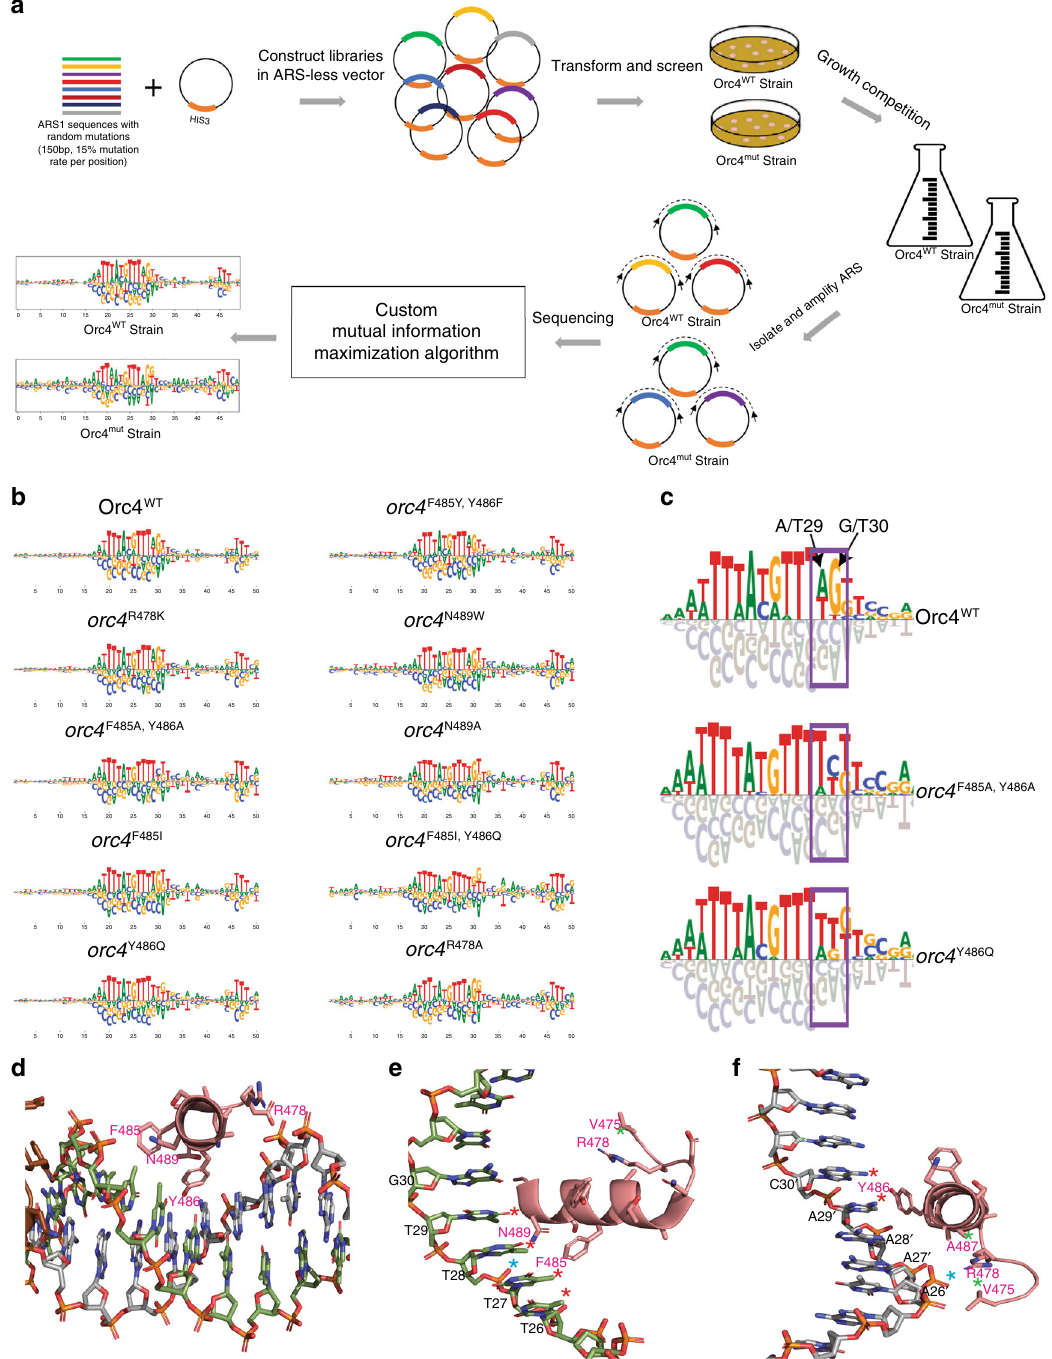
Fig. 2 Selected origin sequence changes using a massively parallel origin selection (MPOS) assay. a Schematic diagram of the MPOS assay. b ARS motifs for Orc4-integrated variants at A and B1 elements generated using an ARS1 (ARS416) variant library. See “ Methods ” for how motifs are graphically rendered. c Magni fi ed view of the A element region in b from Orc4 WT , orc4 F485A, Y486A , orc4 Y486Q strains. Dark purple rectangles indicate the major changes at positions 29 – 30 in the Orc4 mutant strains. d Top-view of Orc4 α -helix insertion from ORC – DNA structure at 3 Å (PDB code 5zr1) positioned in the DNA major groove. F485, Y486, N489, and R478 interact with DNA in base-speci fi c (speci fi city) and base-nonspeci fi c (af fi nity) manner. e and f Same as in d , but viewed at different angles. Red asterisks denote the base-speci fi c interactions between amino acid and DNA base. Blue asterisks denote the base-nonspeci fi c interaction between amino acid and DNA phosphate backbone. Green asterisks denote the interaction between amino acids. Prime symbols denote bases on the opposite strand. Bases numbering denotes the positions in the logo (see b ). e Shows the hydrophobic interaction between F485 and T-rich region T26 – T29, base-speci fi c interaction between N489 and T28, base-nonspeci fi c interaction between N489 and phosphate backbone of T28, and R478 interaction with V475. f Shows the aromatic edge-face interaction between Y486 and A29 ′ on the opposite strand, hydrophobic interaction between Y486 and C30 ′ , base-nonspeci fi c interaction between R478 and phosphate backbone of A27 ′ , and R478 interaction with A487 and